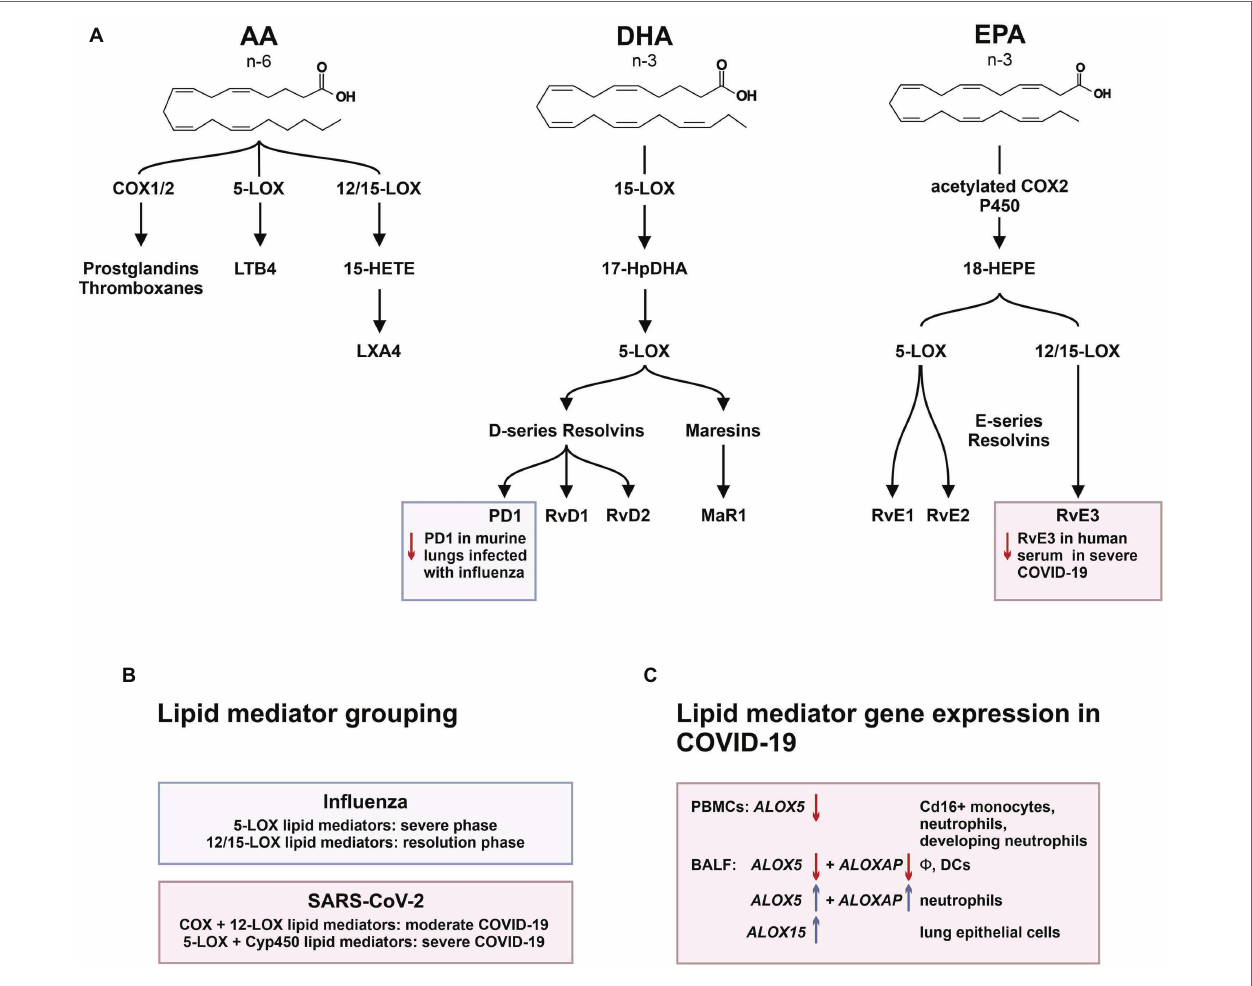
FIGURE 5 | The mediator lipidome in influenza and SARS-CoV-2 infection. (A) The graph summarizes common 6-PUFA- and 3-PUFA-derived bioactive and pro- resolving lipid mediators (AA, arachidonic acid; DHA, docosahexaenoic acid; and EPA, eicosapentaenoic acid). While severe influenza infection showed inhibition of protectin D1 (PD1) synthesis, severe SARS-CoV-2 infection was associated with a significant reduction in E-series resolvin 3 (RvE3). (B) Lipid mediator grouping according to synthetic pathways. (C) Transcriptional regulation of key enzymes involved in lipid mediator synthesis in PBMCs and BALF cells from patients affected by